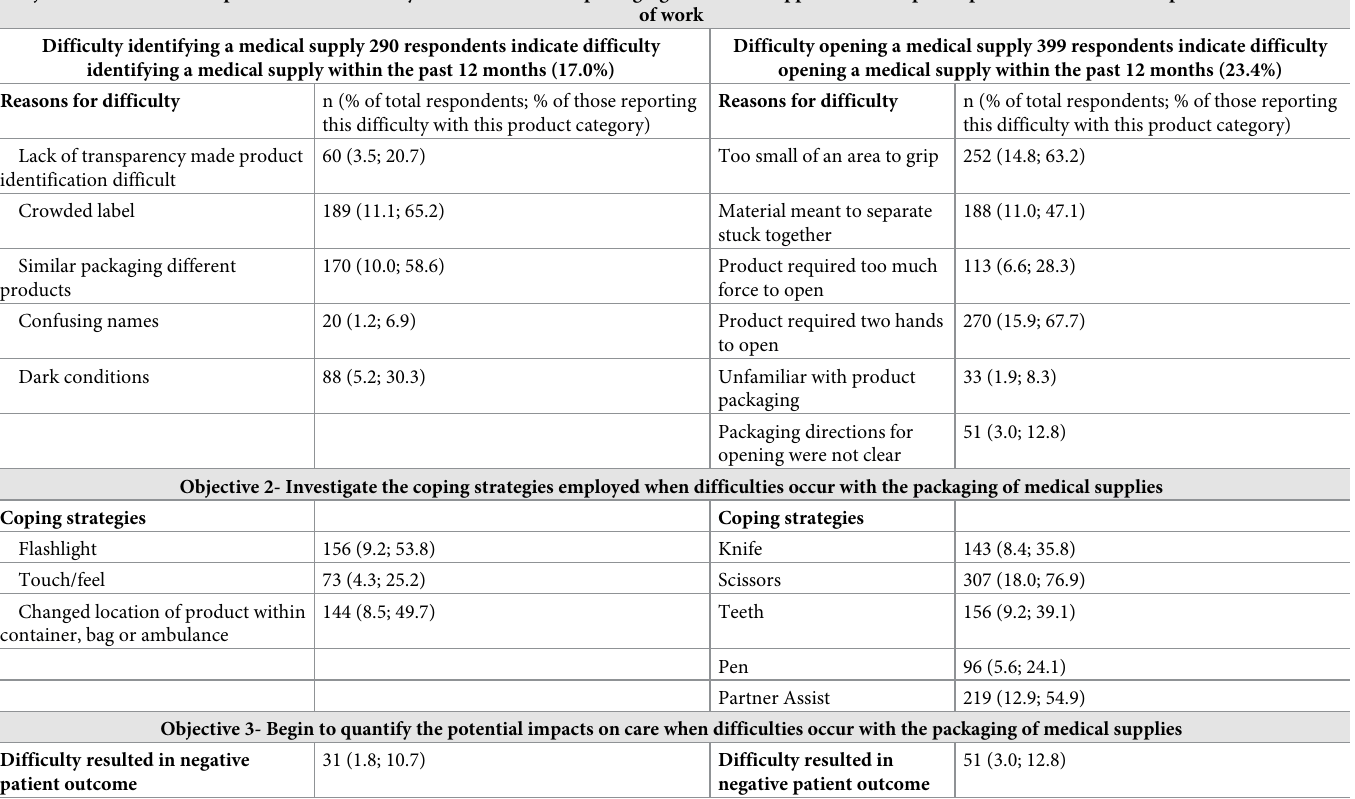
Table 4. Frequencies and proportion of respondents self-reporting difficulty with each task (identifying and opening), resulting coping strategies and negative impact on care related to use of medical supplies within the previous 12 months. Objective 1- Estimate the prevalence of difficulty associated with the packaging of medical supplies with the prehospital context within the previous 12 months of work Difficulty identifying a medical supply 290 respondents indicate difficulty identifying a medical supply within the past 12 months